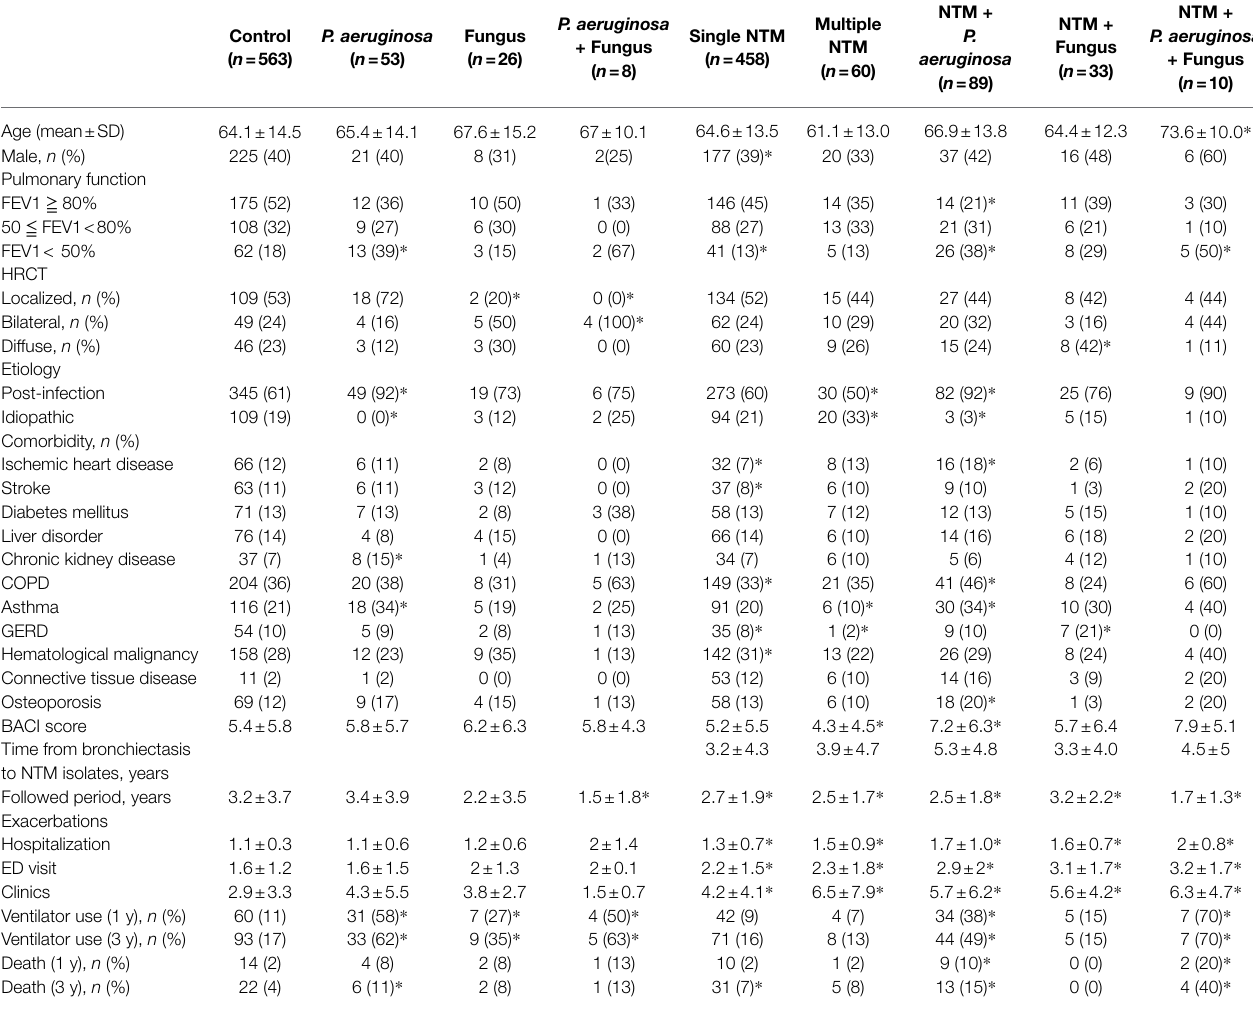
TABLE 1 | Clinical characteristics of non- CF bronchiectasis patients in the six groups according to the pathogen isolated from sputum samples.